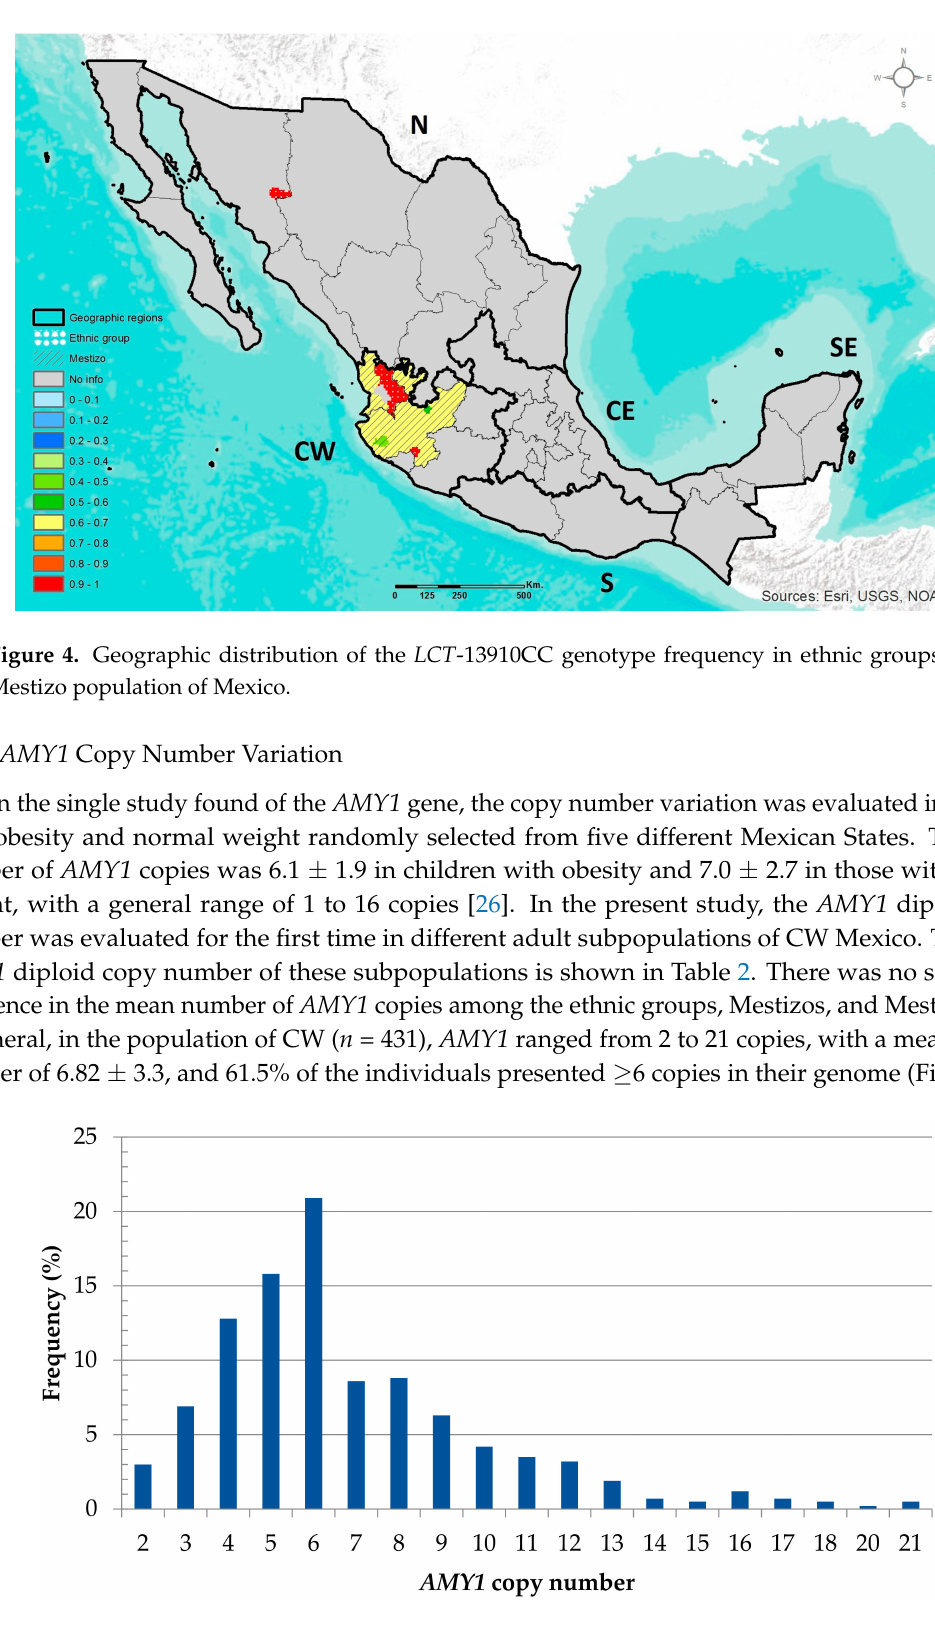
Figure 5. Distribution of the AMY1 gene diploid copy number in general adult population of CW